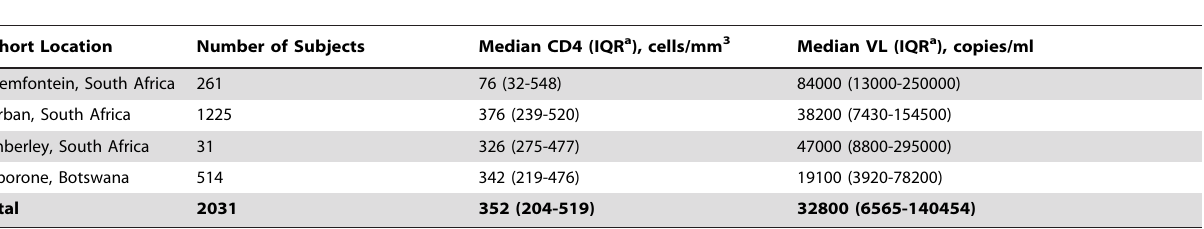
Table 1. Characteristics of 2031 Southern African adult subjects with C-Clade HIV-1 infection enrolled in four cohorts.